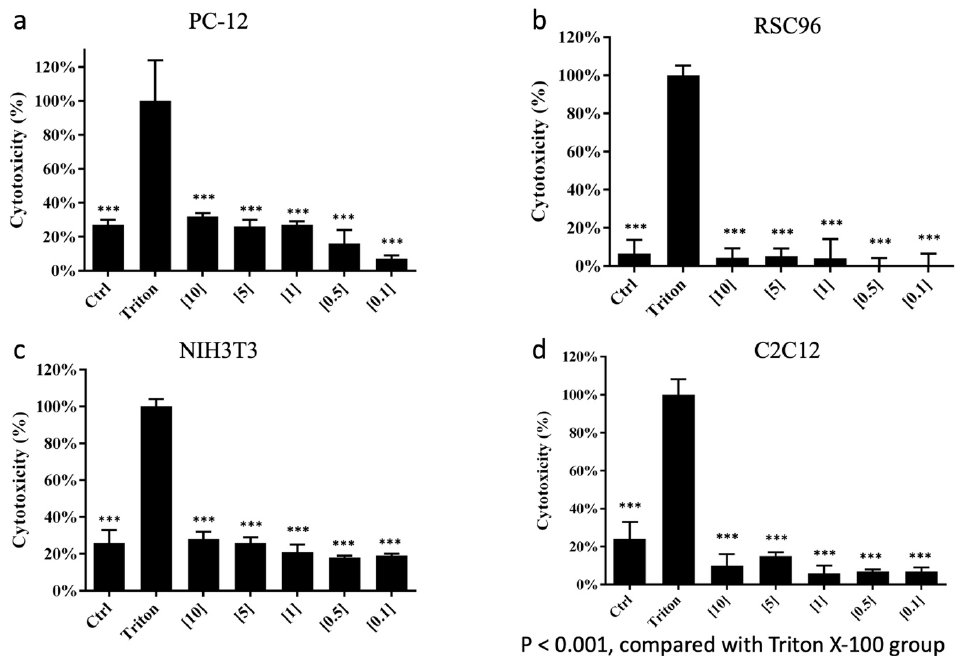
Figure 6. ( a , c ) Higher cytotoxicity was observed in PC-12 and NIH/3T3 cell lines after culture in high-concentration of CMC/BSP (10, 5, and 1 mg/mL)/RES sponge (cytotoxicity > 20%) using the LDH assay kit. ( b , d ) There were no significant differences between RSC96 and C2C12 cell lines after culture in CMC-BSP-RES sponges at different concentrations. ***: p < 0.001.